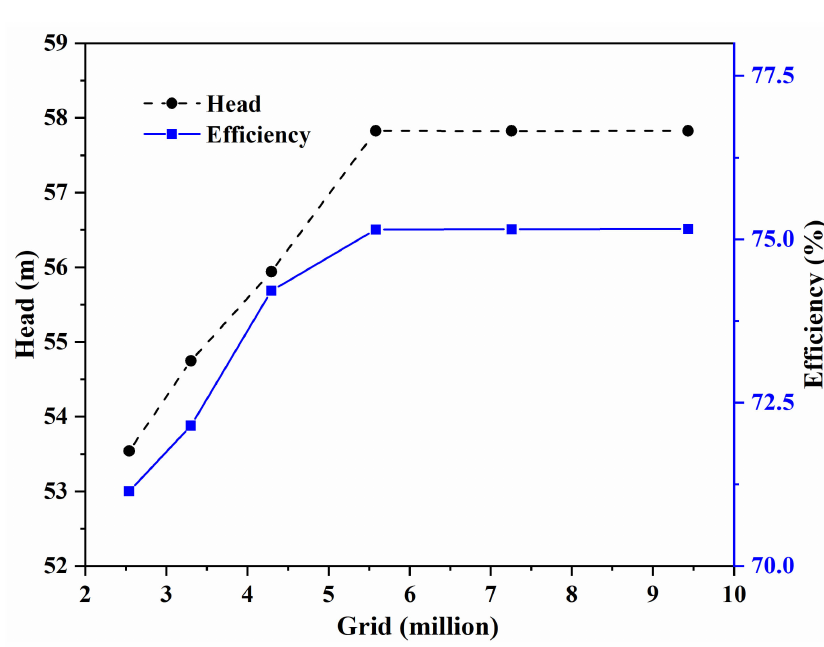
Figure 4. Grid independence